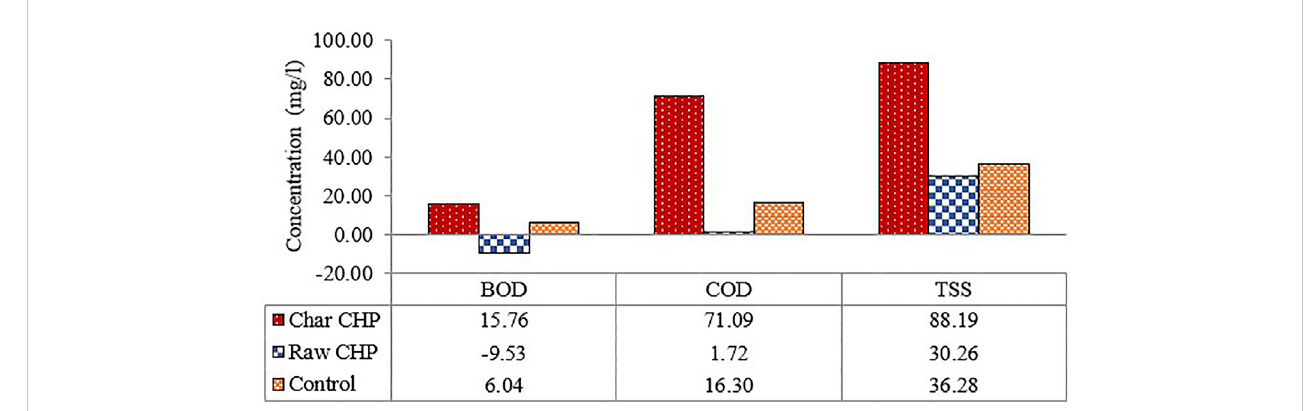
FIGURE 6 Effect of pyrolysis on organic matter removal.